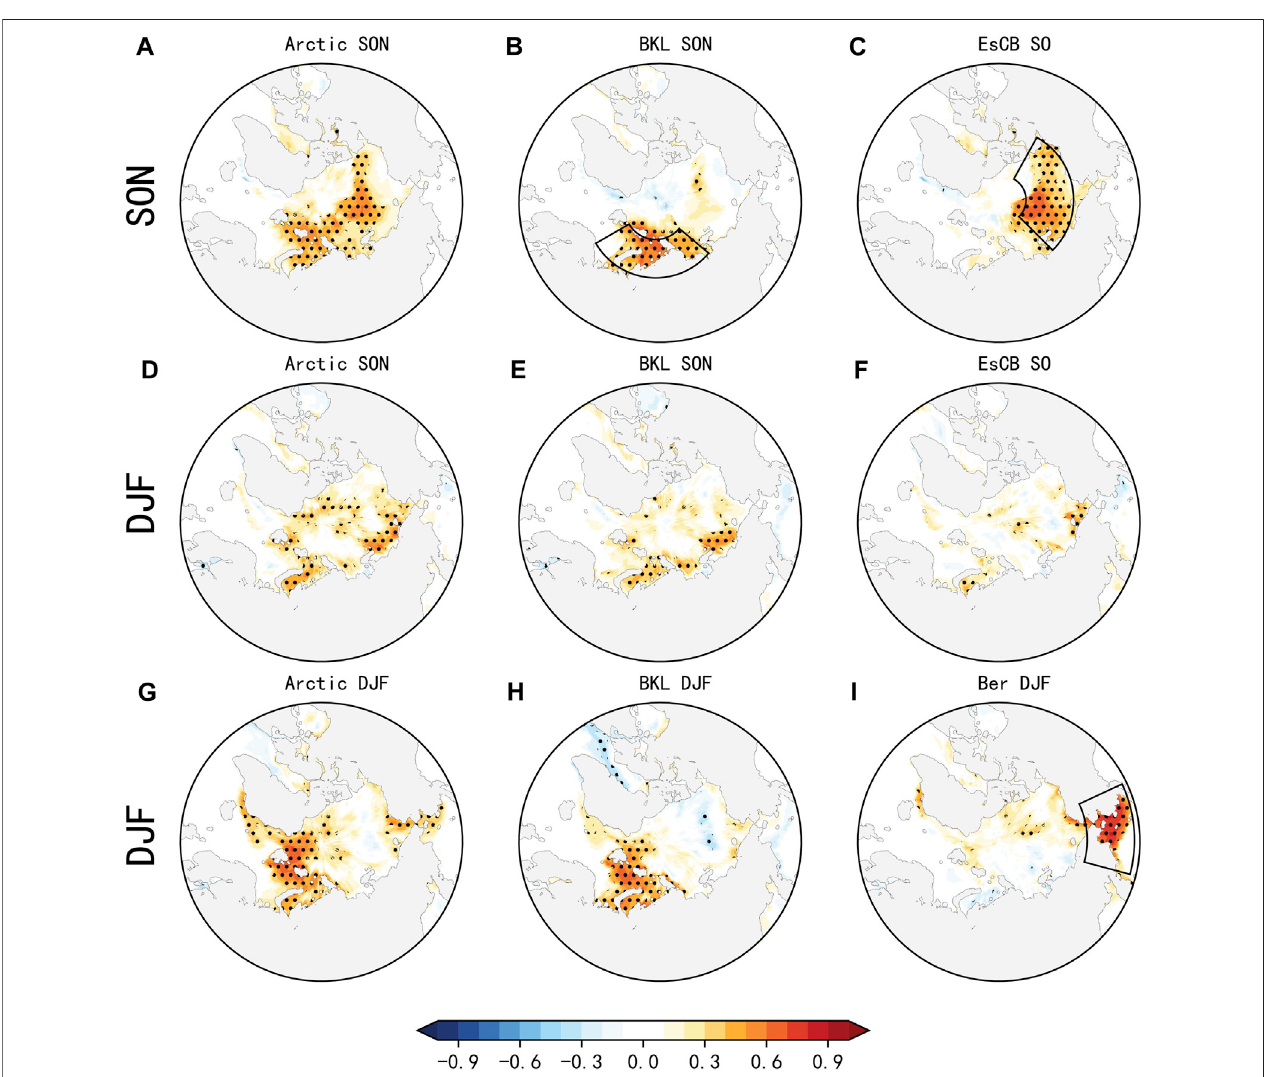
FIGURE2| Linearregressionof (A – C) autumnand (D – F) winterArcticSICwithrespecttoregionalSICindicesinthePan-Arctic,BKLandEsCBinautumn. (G – I) As in (A – C) but for winter SIC anomalies regressed upon winter indices. Rectangles denote the region to de fi ne BKL, EsCB, and Ber indices. Stippling indicates regression anomalies that are statistically signi fi cant at the 95% con fi dence